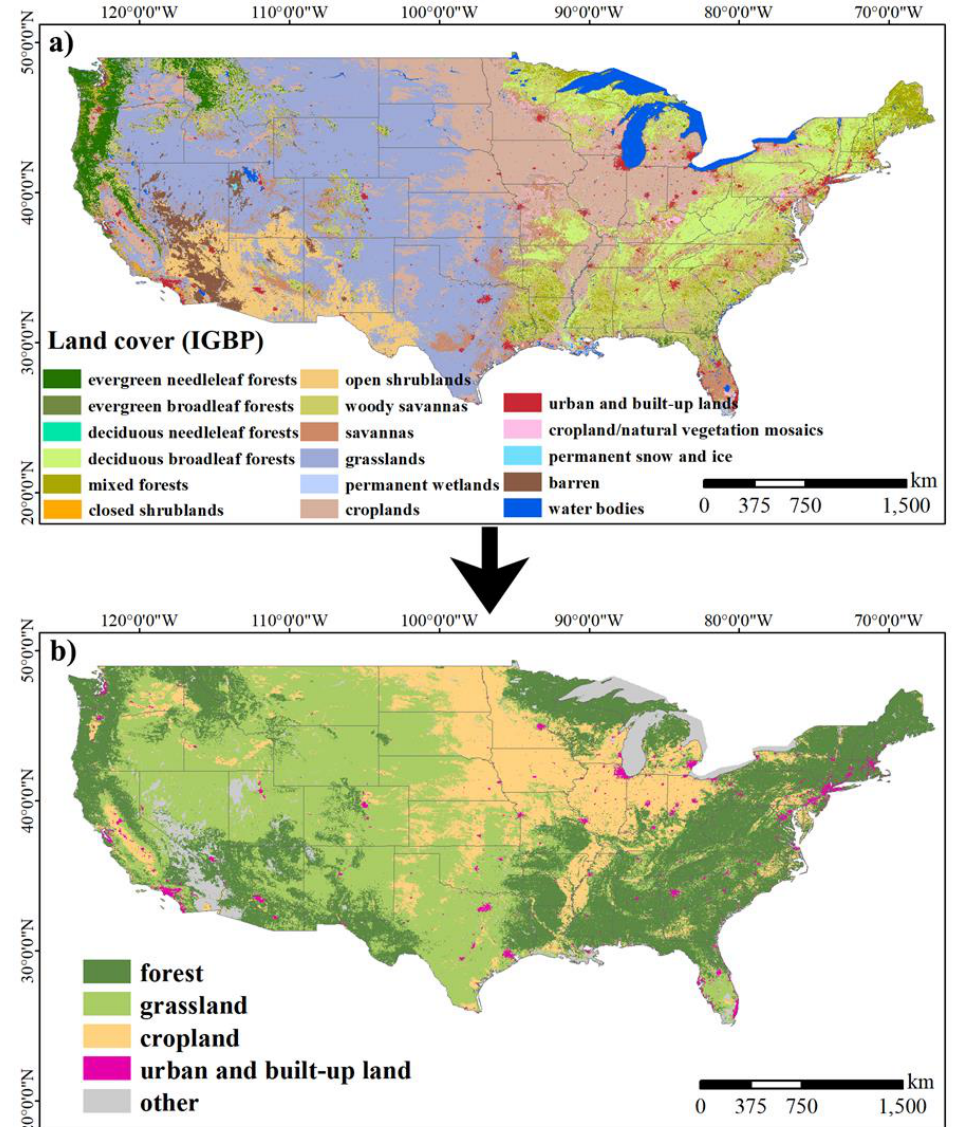
Figure 1. Land cover types in the conterminous United States, where a ) denotes the IGBP classifi- cation scheme, and b ) denotes the four categories required for this study. tion scheme, and ( b ) denotes the four categories required for this